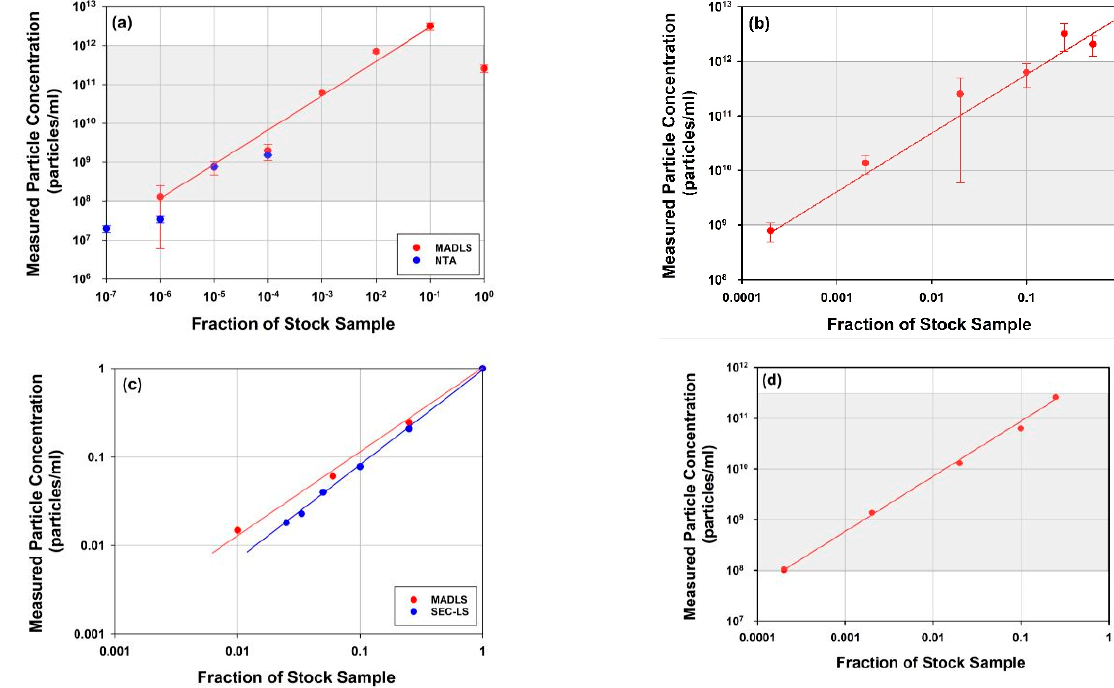
Figure 4. Examples of accessible concentration range for delivery vectors of different sizes. ( a ) Lipo- some sample (~100 nm) measured by MADLS and NTA; ( b ) LNP 1 (~87 nm) measured by MADLS; ( c ) full rAAV5 (~30 nm) measured by MADLS and SEC-SLS (the measurements were done on two dif- ferent batches with different stock concentrations 8 × 10 13 and 3.1 × 10 13 particles/mL, respectively); ( d ) LNP2 (~104 nm) measured by MADLS. Indicated particle sizes (in brackets) are main population diameter in MADLS measurements. Shaded on each graph is the theoretical region for concentration based on the particle size and optical properties such as particle refractive index and absorbance.